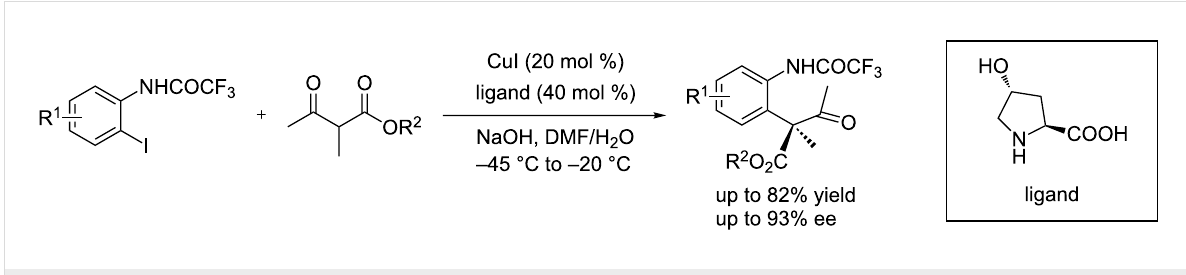
Scheme 15: Enantioselective arylation reactions of 2-methylacetoacetates.